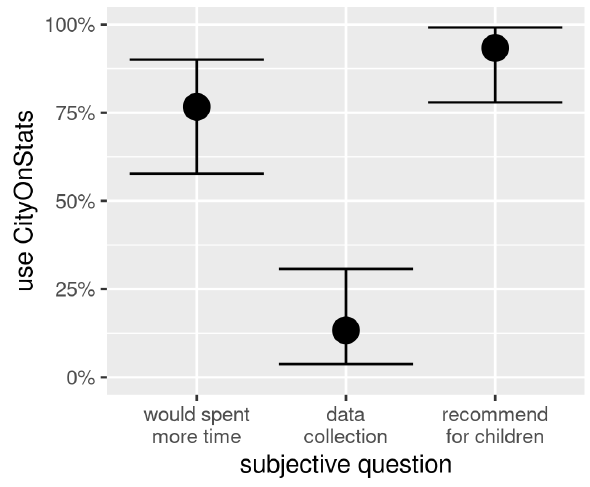
Figure 17. Plot of the “CityOnStats” answers to the subjective questions “Would you spend more time using CityOnStats or the website?”, “Would you prefer using CityOnStats or the website to collect data in future?”, “Would you prefer using CityOnStats or the website to transmit pollution-related knowledge to children?” Dots and error bars represent averages and 95% CI (binomial test),